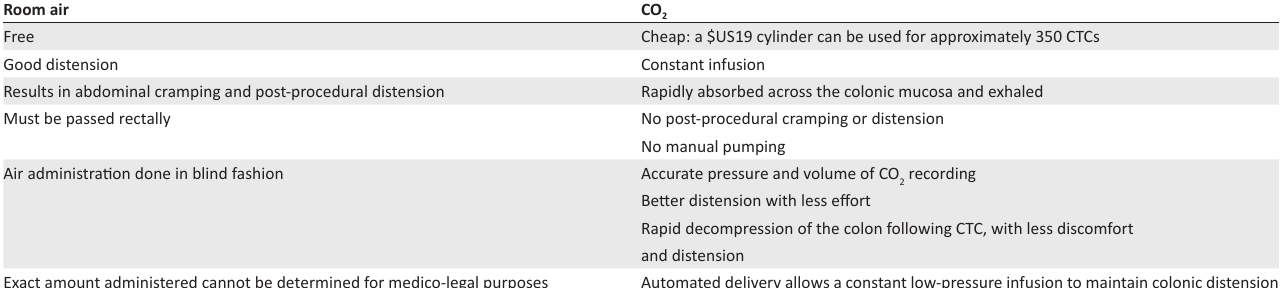
TABLE 2: Room air versus CO 2 . Room